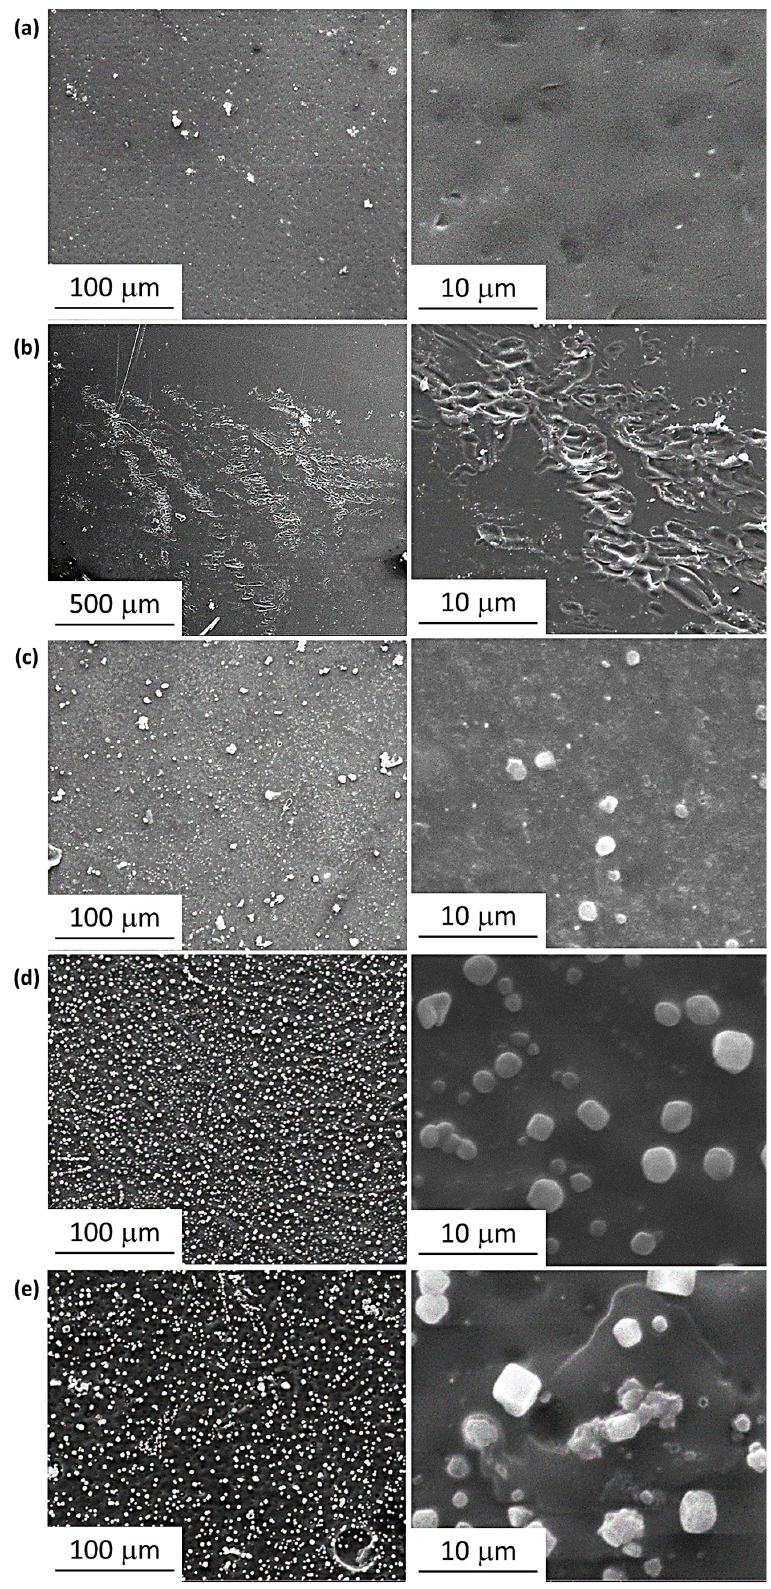
Figure 9. SEM Images of ( a ): PVC/L/Ti NPs, ( b ): PVC/L/Cu NPs, ( c ): PVC/L/Co NPs, ( d ): PVC/L/Cr NPs, and ( e ): PVC/L/Ni NPs after irradiation (300 h).